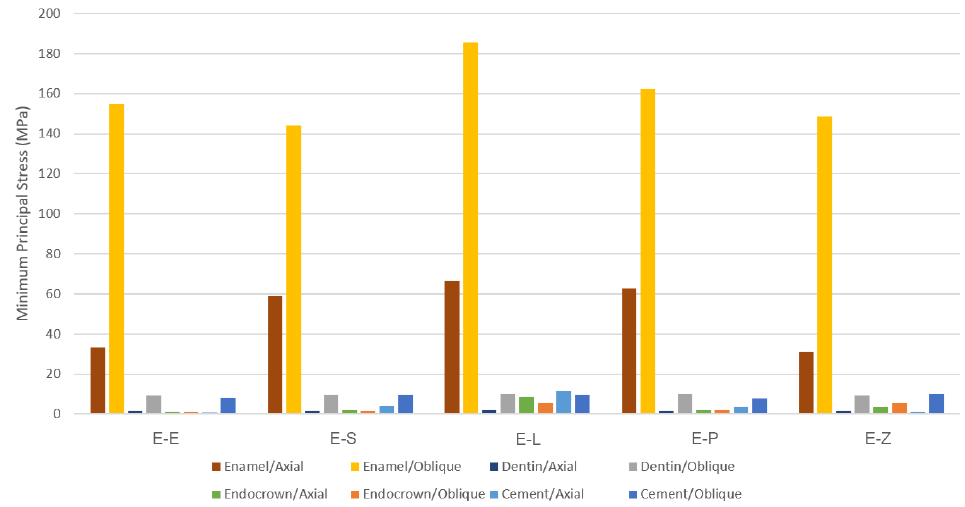
Figure 7. The maximum values of minimum principal stresses (MPa). E-E: lithium disilicate glass ceramic model, E-S: zirconia-reinforced lithium silicate ceramic model, E-L: resin nanoceramic model, E-P: polymer-infiltrated ceramic network model and E-Z: translucent zirconia model.